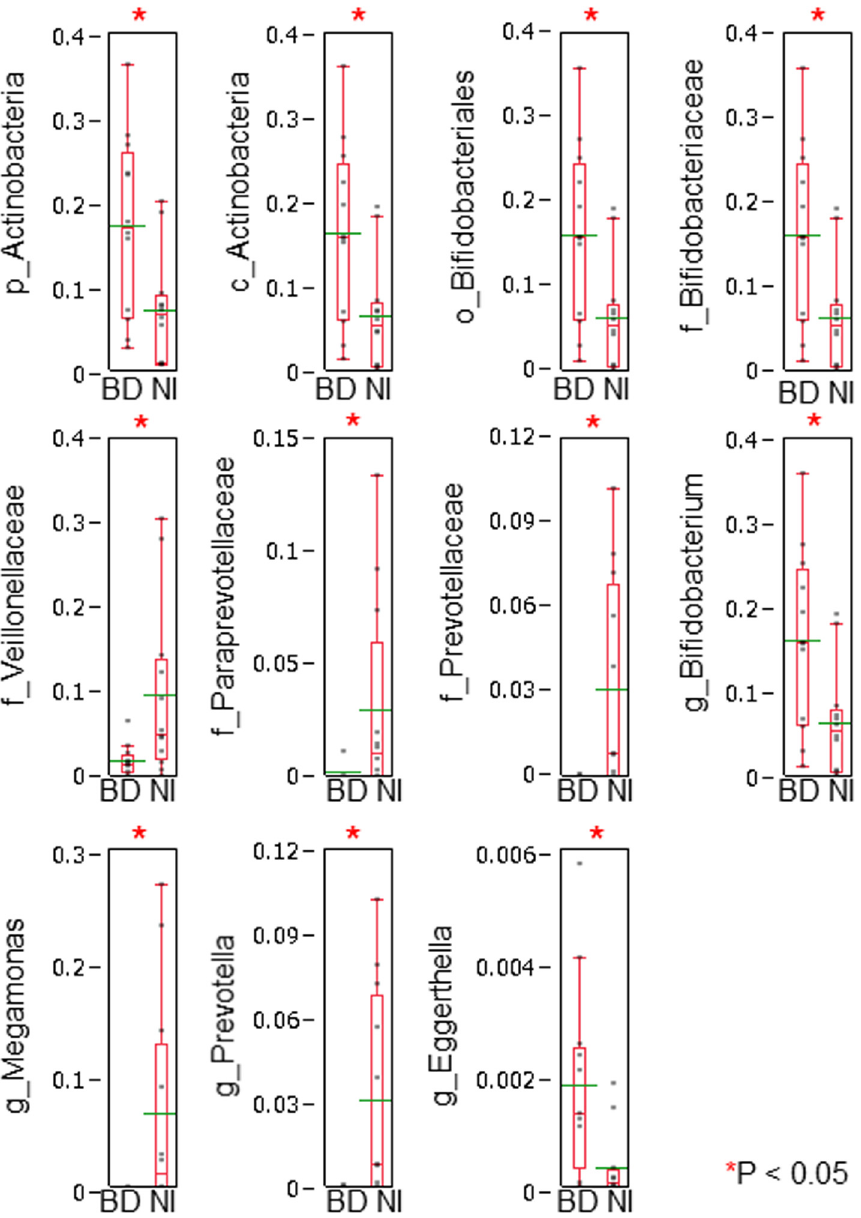
Fig 1. Direct comparison of bacterial taxonomic abundance between BD patients and normal individuals. We compared directly the relative abundance (expressed as parts per unit) between BD patients (BD) and normal individuals (NI). We conducted Wilcoxon rank sum test for the differences in every taxon, followed by Tukey ’ s honestly significant difference (HSD) test. We considered that bacterial taxa increased or decreased significantly in patients with BD as compared with those in normal individuals by fulfilling the following criteria simultaneously; #1: bacterial taxa showing significant differences by the Wilcoxon rank sum test, and #2: bacterial taxa showing positive Tukey ’ s HSD values. We found that there were significant differences in 11 bacterial taxa (also shown in Fig 2 with asterisks). “ p__ ” , “ c__ ” , “ o__ ” , “ f__ ” and “ g__ ” indicate phylum, class, order, family and genus, respectively. Relative abundance of bacterial taxa in BD patients and normal individuals were displayed with dot plots. A box-plot and a mean level (green line) of each group of BD patients and normal individuals were